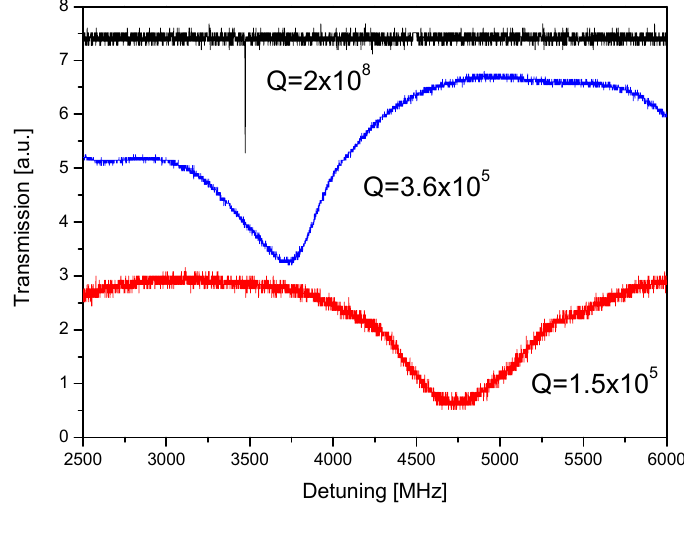
Figure 3. Measured Q factor of the NT sample (black line), of a covalent binding of IgG (blue line) and an IgG/anti-IgG interaction (red line).